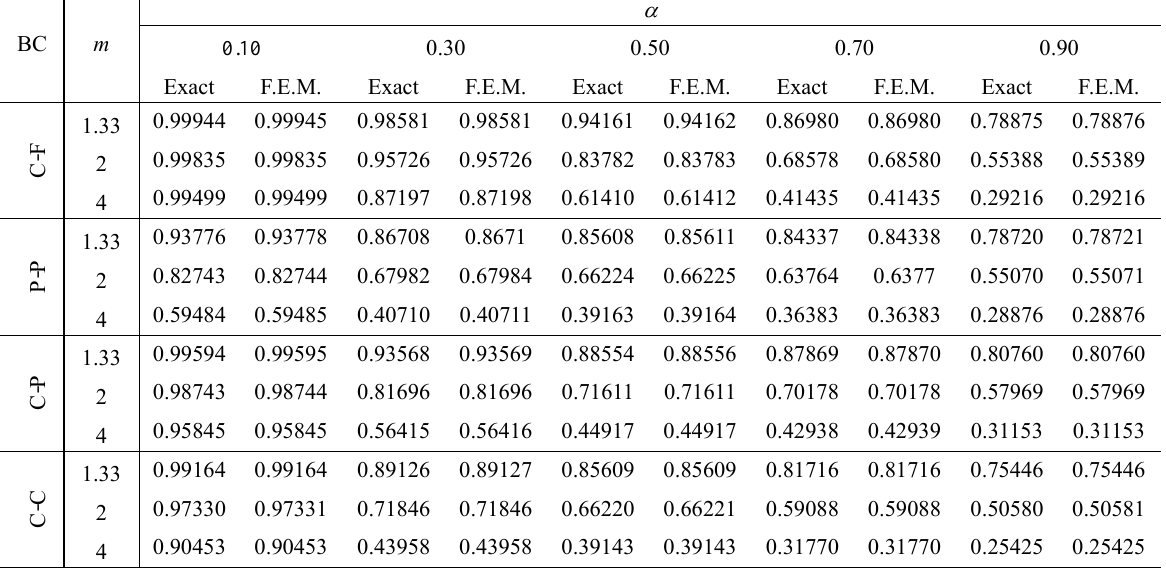
Comparison of the buckling load factor A For uniform column ( n =1.0).